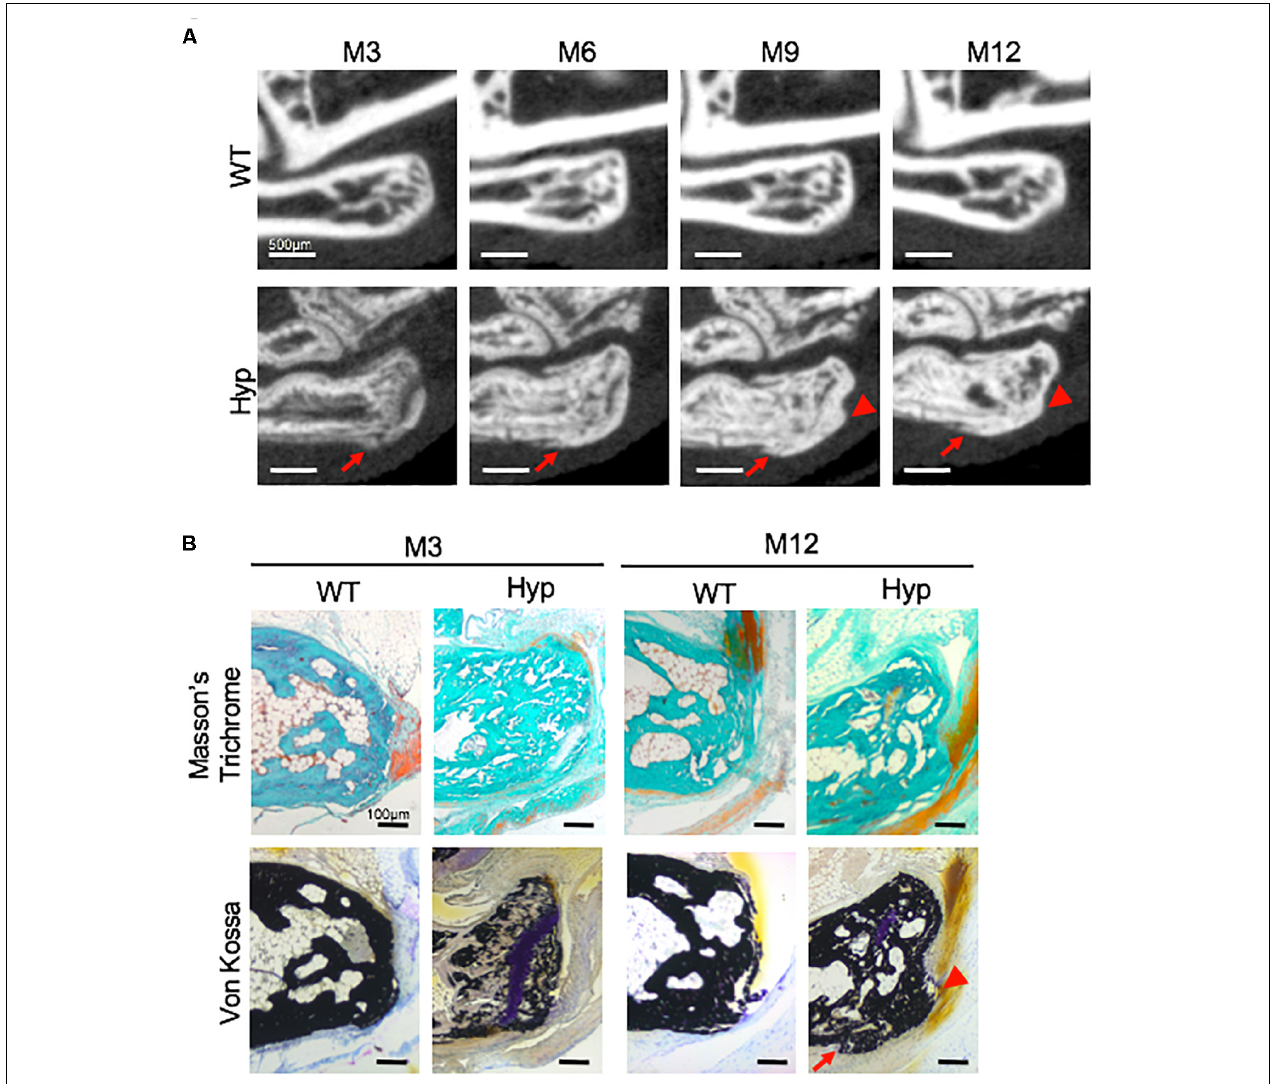
FIGURE 3 | Calcaneal enthesophytes in Hyp mice. (A) Achilles (red arrowheads) and plantar fascia enthesophytes (red arrows) developed from M3 to M12 in Hyp mice (representative micro-CT sections from Hyp# 4 mouse). In contrast, no enthesis ossification was found in WT littermates (scale bars, 500 µ m). (B) Masson’s trichrome and Von Kossa staining of undecalcified sections of calcaneal area at M3 and M12 in WT and Hyp mice. Von Kossa staining confirmed the cellular expansion of mineralizing fibrochondrocytes into Achilles tendon (red arrowhead) and plantar fascia ligament (red arrow) insertions of the calcaneal tuberosity in Hyp mice (scale bars, 100 µ